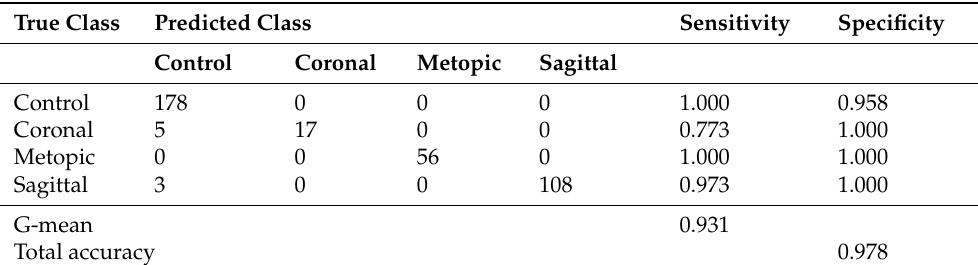
Table 1. Confusion matrix, sensitivity, and specificity for linear discriminant analysis (LDA), nonrigid iterative closest points affine (N-ICP-A) and the optimal number of components (44) using